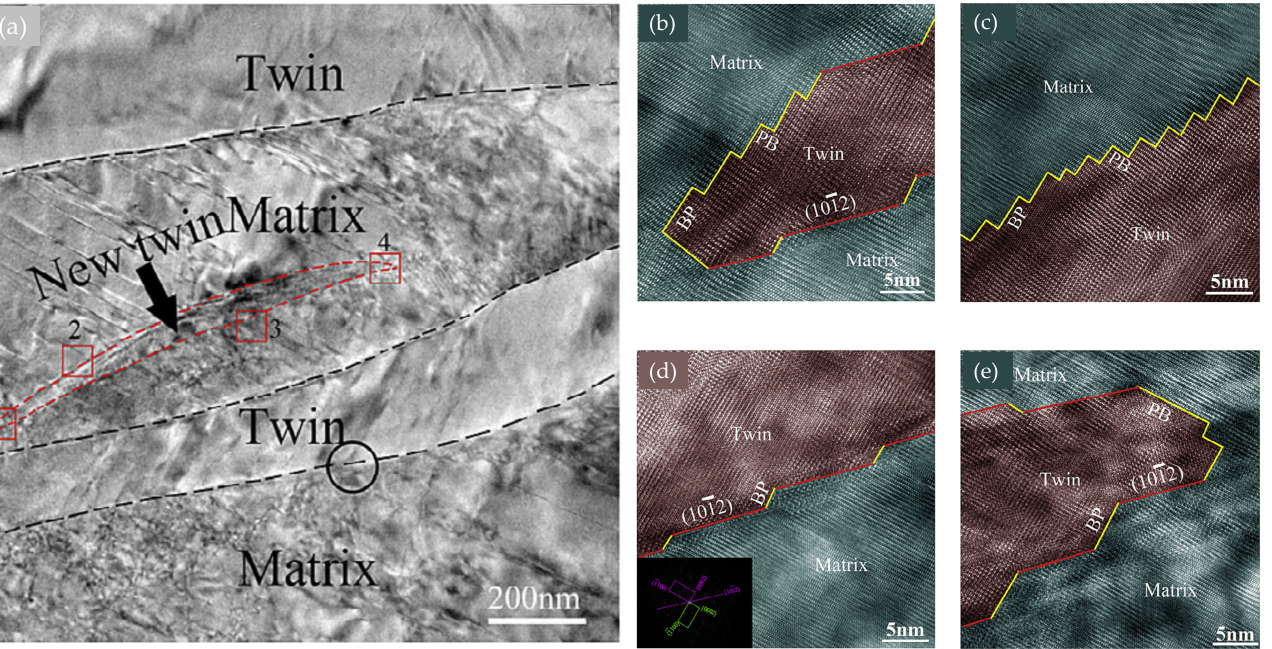
Figure 2. Microstructural features of the twin nucleus arrowed in ( a ) transmission electron microscopy images showing ( b ) area 1; ( c ) area 2; ( d ) area 3; and ( e ) area 4. The { 1012 } coherent twin boundaries and BP/PB boundaries are colored in red and yellow, respectively. Reproduced from [43], with permission from Elsevier